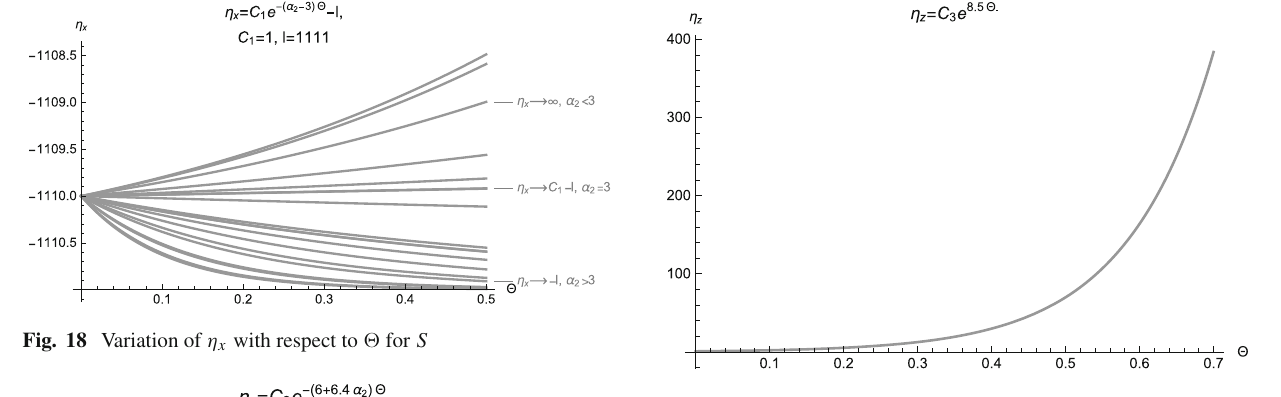
Fig. 20 The variation of η z with respect to (cid:16) for S at γ = 0